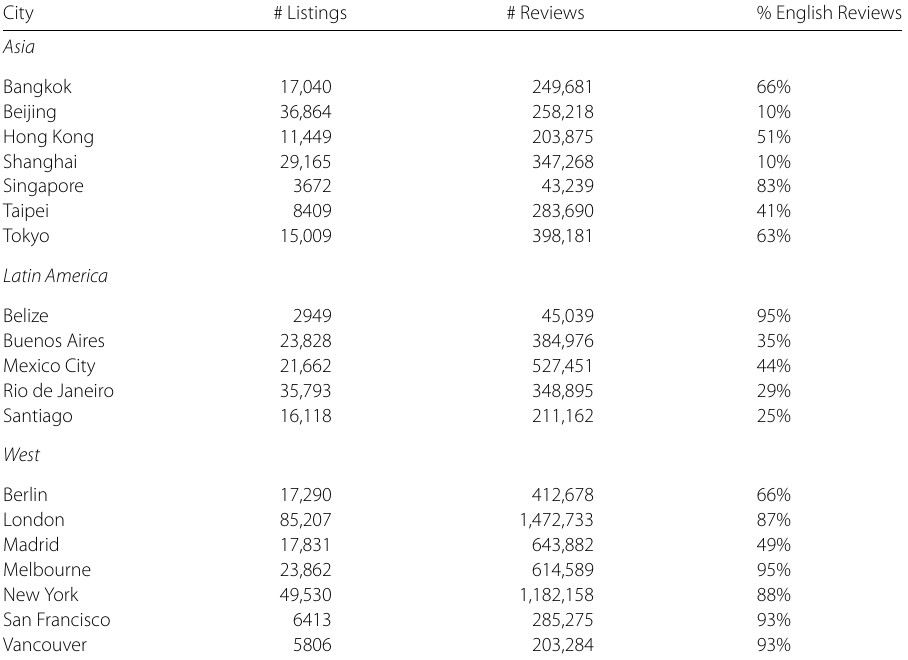
Table 1 Listings and reviews in Asian, Latin American, and Western cities City # Listings #